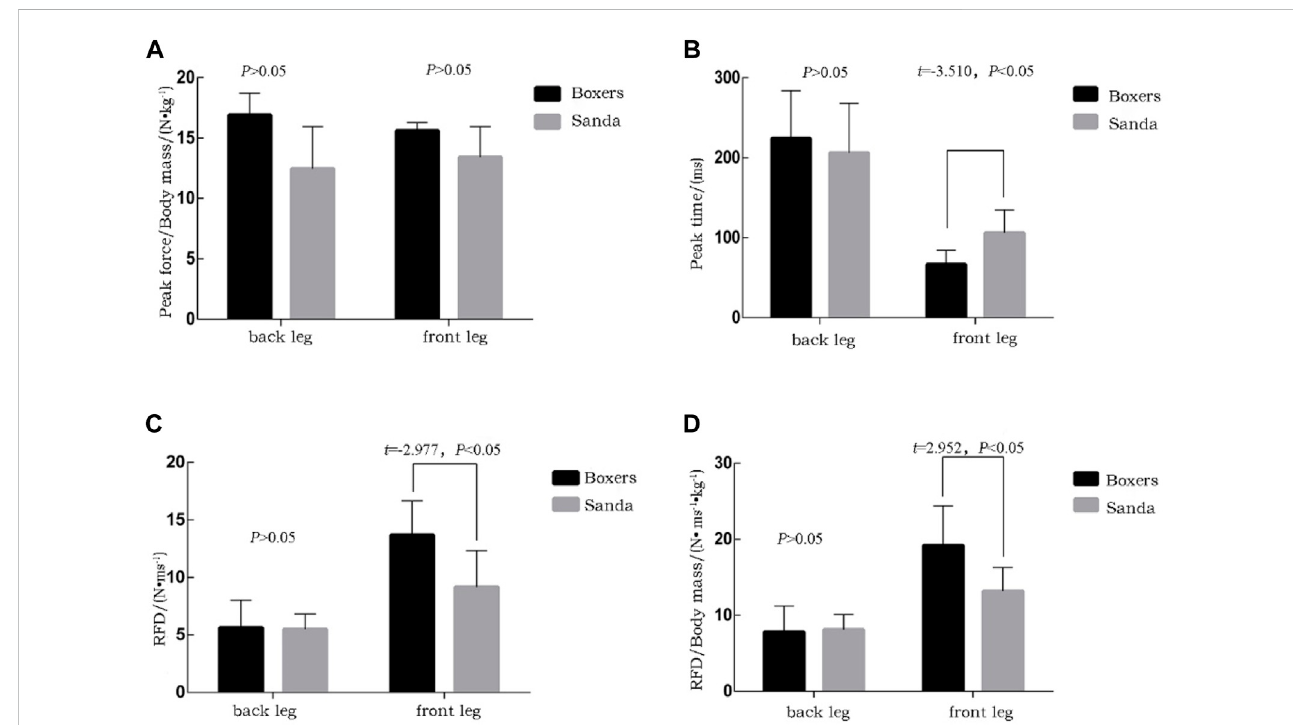
FIGURE 5 (A) peaklowerlimbforcedividedbybodyweightforboxersandSandaathletes; (B) timetopeakforceinlowerlimbs; (C) athletes ’ lowerlimbrateofforce development and (D) relative rate of force